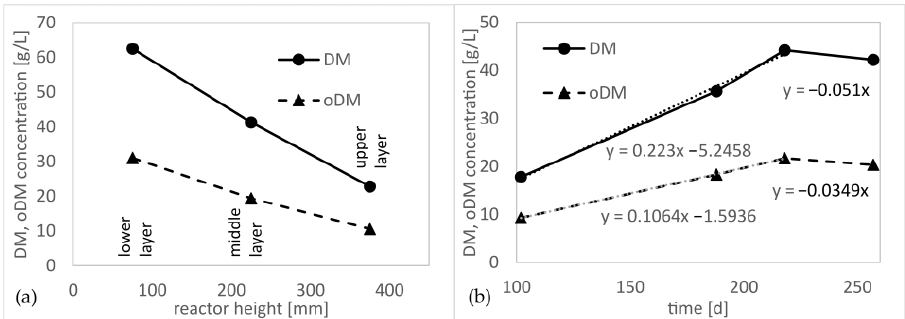
Figure 6. Dry matter (DM) and organic dry matter (oDM) concentration in the reactor, ( a ) depending on the position for day 257 and ( b ) depending on time, rates for days 102 – 218 are marked.